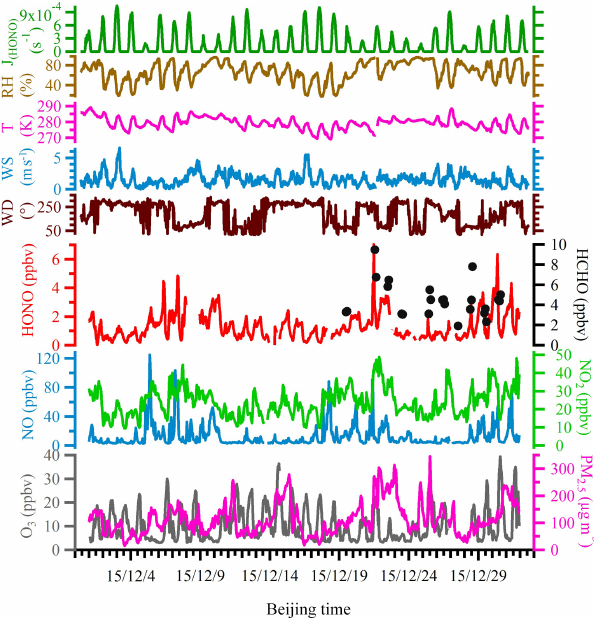
Figure 2. Time series of meteorological parameters, including HONO photolysis frequency ( J( HONO ) ), relative humidity (RH), ambient temperature, wind speed and wind direction, as well as mixing ratios of measured HONO, HCHO, NO, NO 2 , O 3 and PM 2 . 5 during the observation